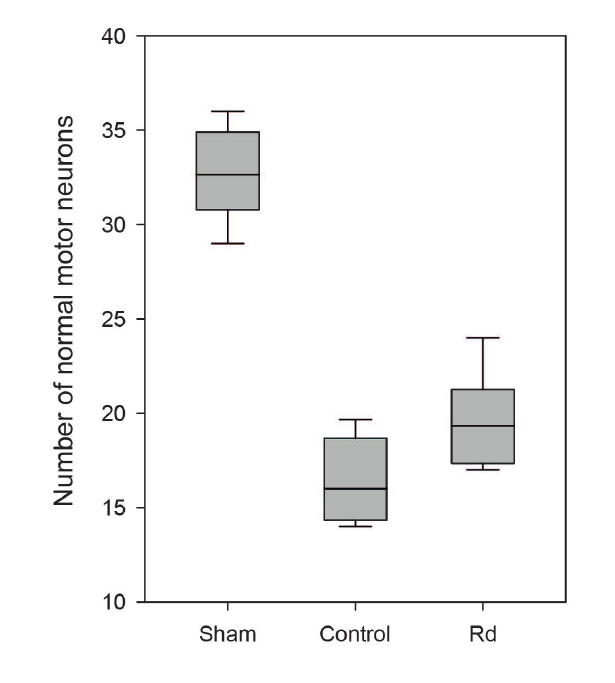
Fig. 2 - Boxplot of the number of normal motor neurons in each group. Significantly fewer normal motor neurons were detected in groups with spinal cord ischemia than in the sham group (P<0.001).